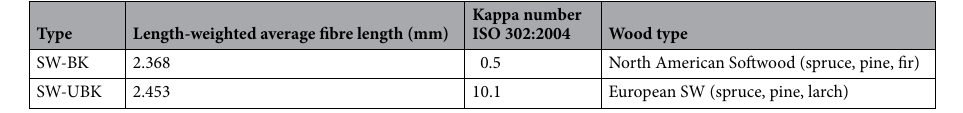
Table 1. Specifications of the used pulp